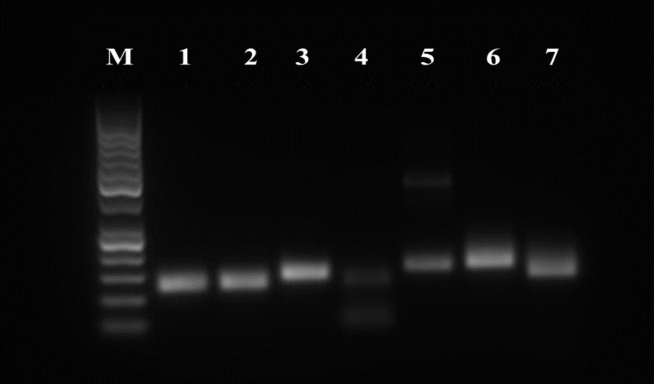
Figure 6. RT-PCR analysis of the expression of rAT-MSCs pluripotency markers. Lane M—50 bp DNA ladder (Thermo Fisher Scientific, USA); lane 1—B2M (control); lane 2—ST3GAL2; lane 3—ALPL; lane 4—NANOG; lane 5—OCT4; lane 6—SOX2; lane